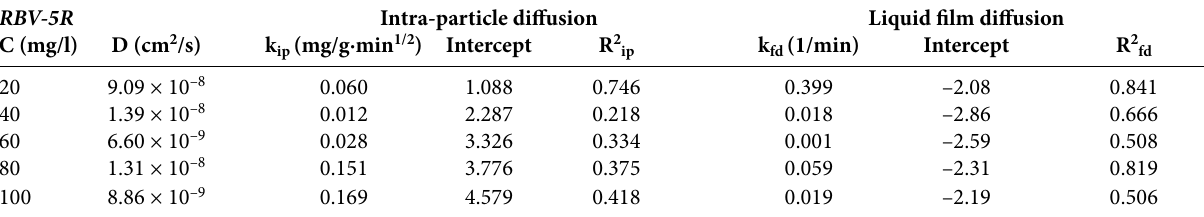
Table 6. Parameters of diffusion models (C i = 20–100 mg/L, 1.5 g biomass, 160 µm, 700 rpm, pH = 6.0 ± 0.2, T = 20 ± 1 °C, P = 1atm)